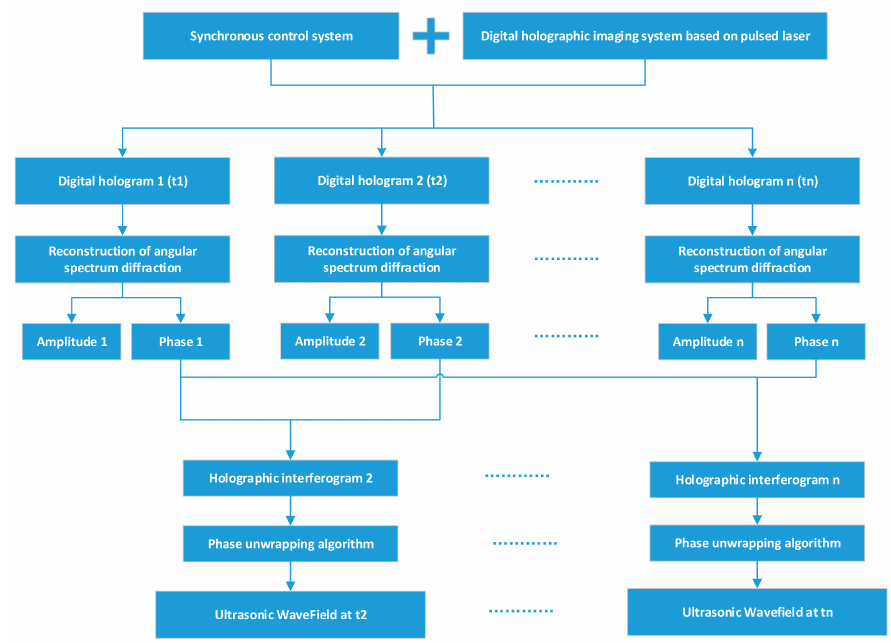
Figure 3. Flow chart of measurement of 3D ultrasonic wavefields.